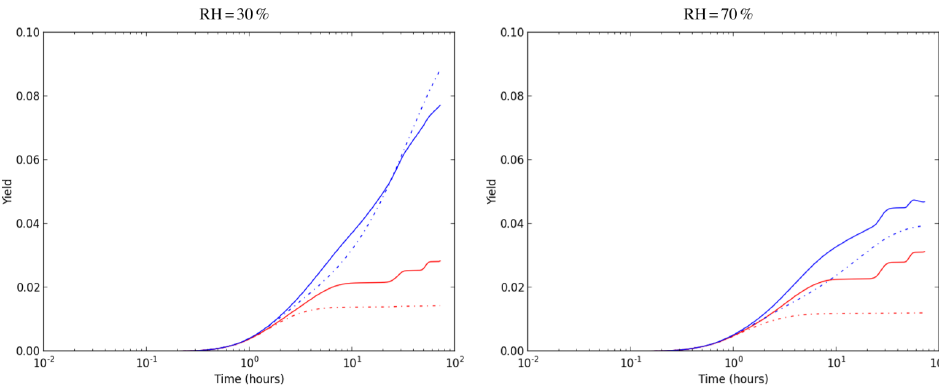
Figure 7. Evolution of the SOA yield from trimethylbenzene oxidation as a function of time for an organic mass loading of 5µgm − 3 . Solid lines correspond to SOA formation with aging. Dashed-dotted lines correspond to SOA formation without aging.